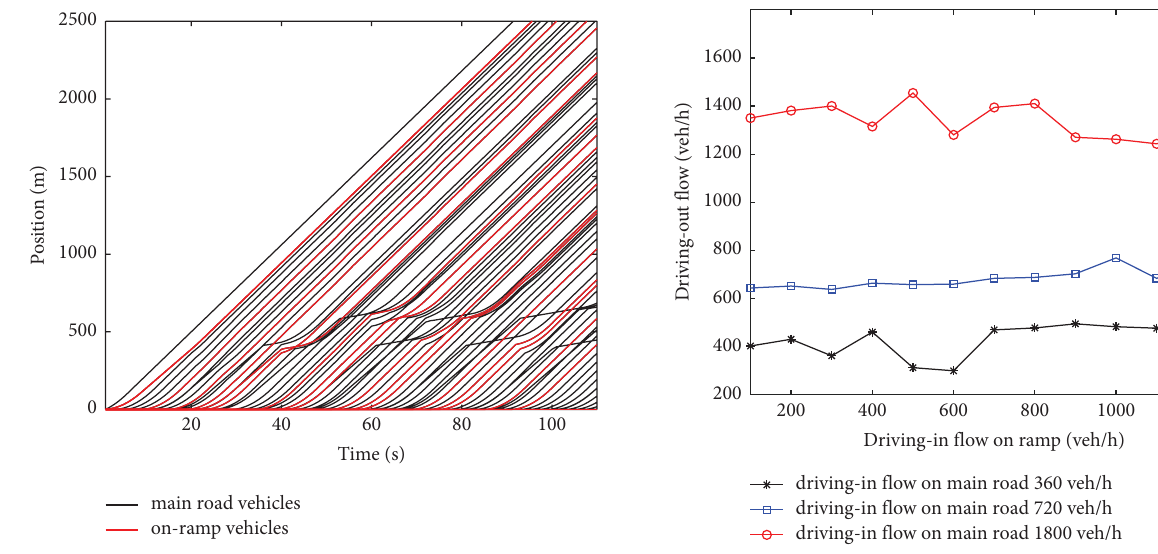
Figure 9: Trajectories with merging vehicles.